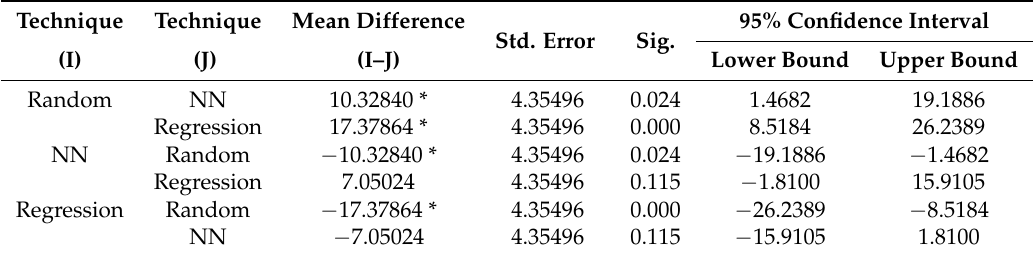
Table 7. Multiple Comparisons (Random, NN and our Regression) significant with respect to the Error Rate. * The mean difference is significant at the 0.05 level.